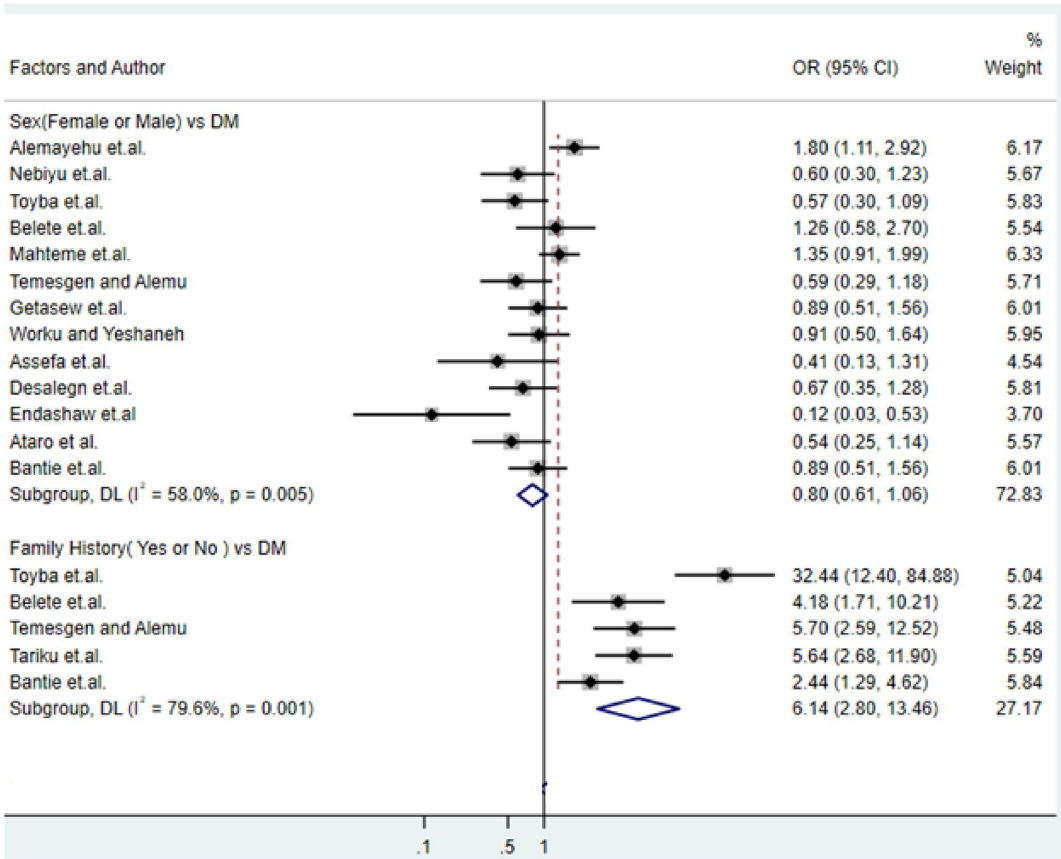
Figure 7. Forest plots of odds ratio for the association of sex and family history with type-2 diabetes.